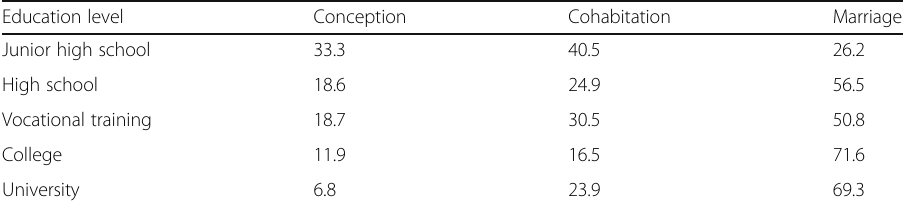
Table 5 Percentage of Japanese women aged 20 – 49 years in a union who experienced union formation by conception, cohabitation or marriage, by education; 2009 Education level Conception Cohabitation Marriage Junior high